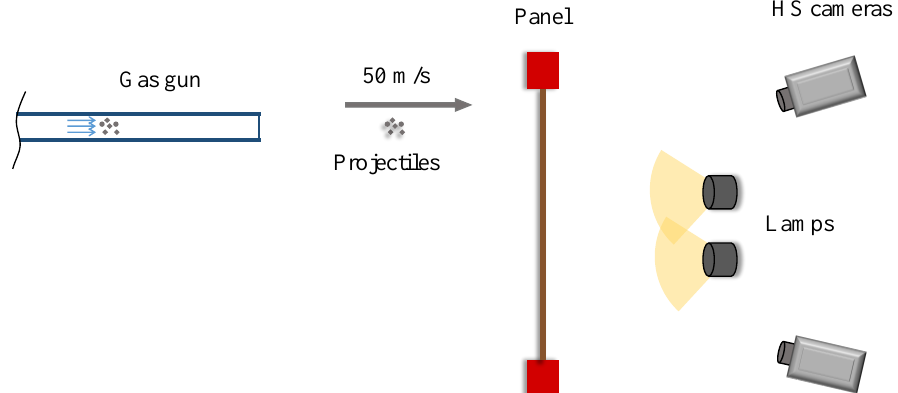
Figure 2. Schematic of the experimental setup for HS 3D-DIC measurement of the vibration re- sponse of a CFRP panel to multi-impact excitation using a gas gun.